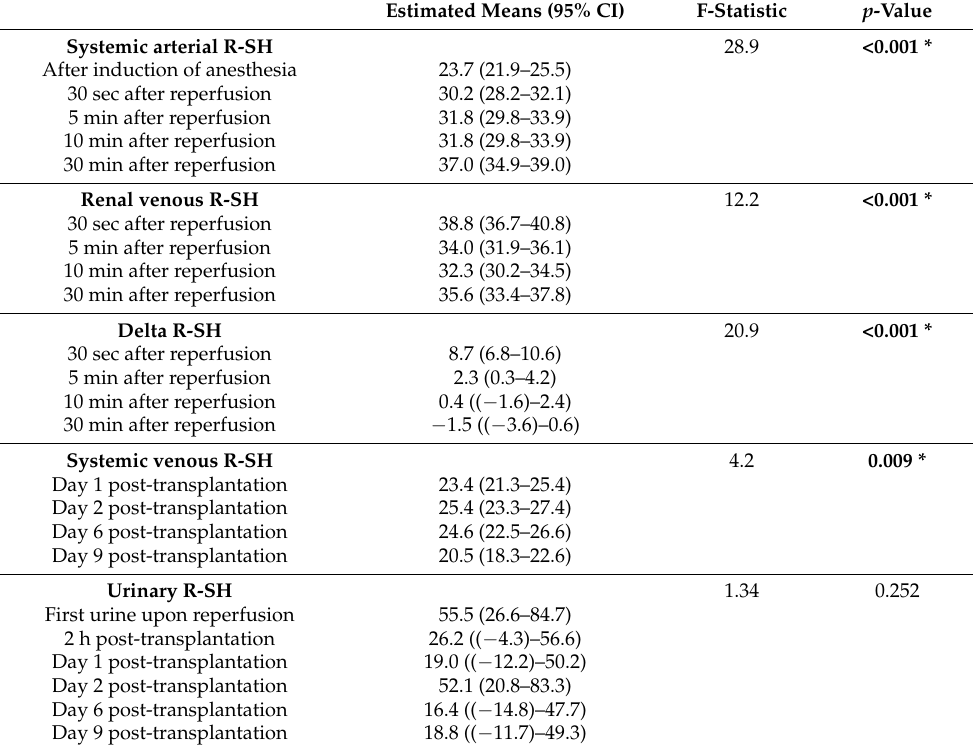
Table 3. Results of linear mixed models: time as